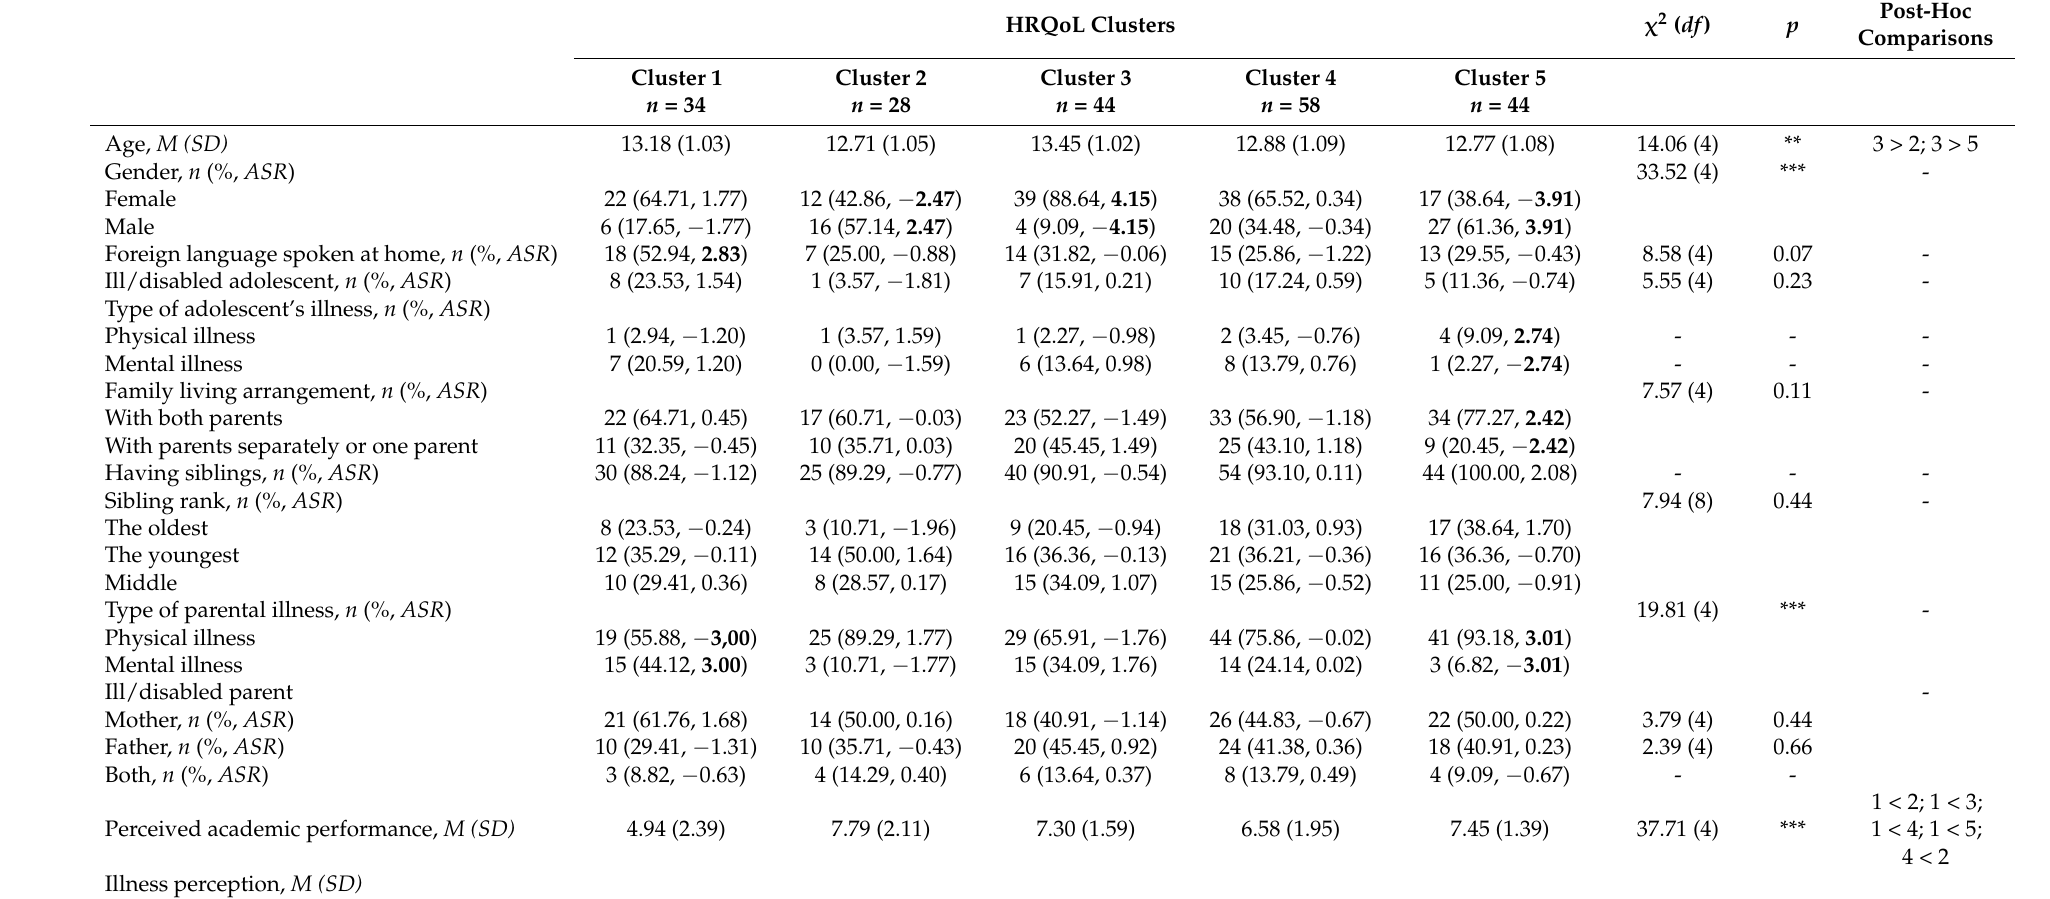
Table 2. HRQoL Cluster